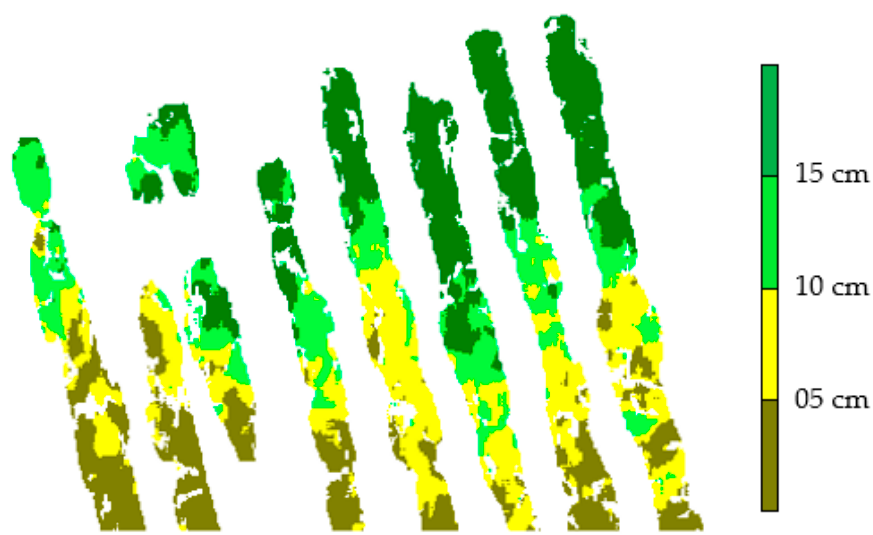
Figure 11. Growth map of the coffee crop from 11 December 2018, to 17 April 2019.